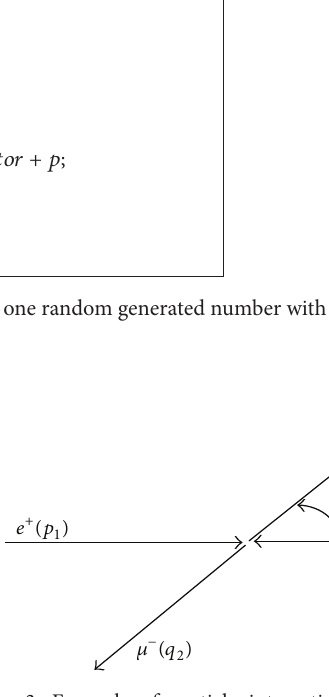
Figure 3: Example of particle interaction: 𝑒(𝑝 1 ) + 𝑒 − (𝑝 2 ) → )𝜇 − (𝑞 ) 𝜇 + (𝑞 1 2